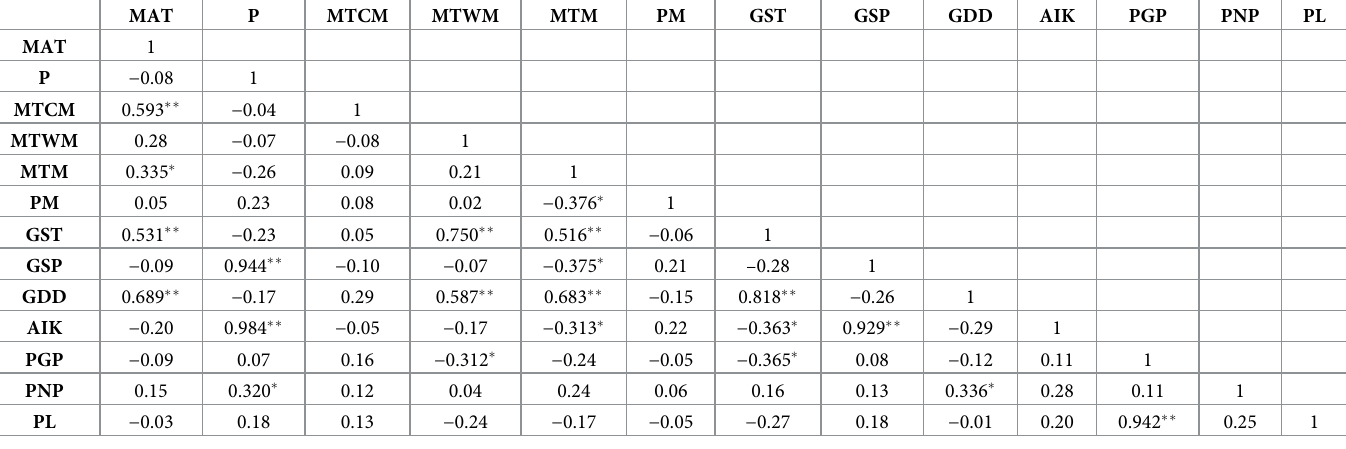
� Significantly correlated at the 0.05 level (bilateral) �� significantly correlated at the 0.01 level